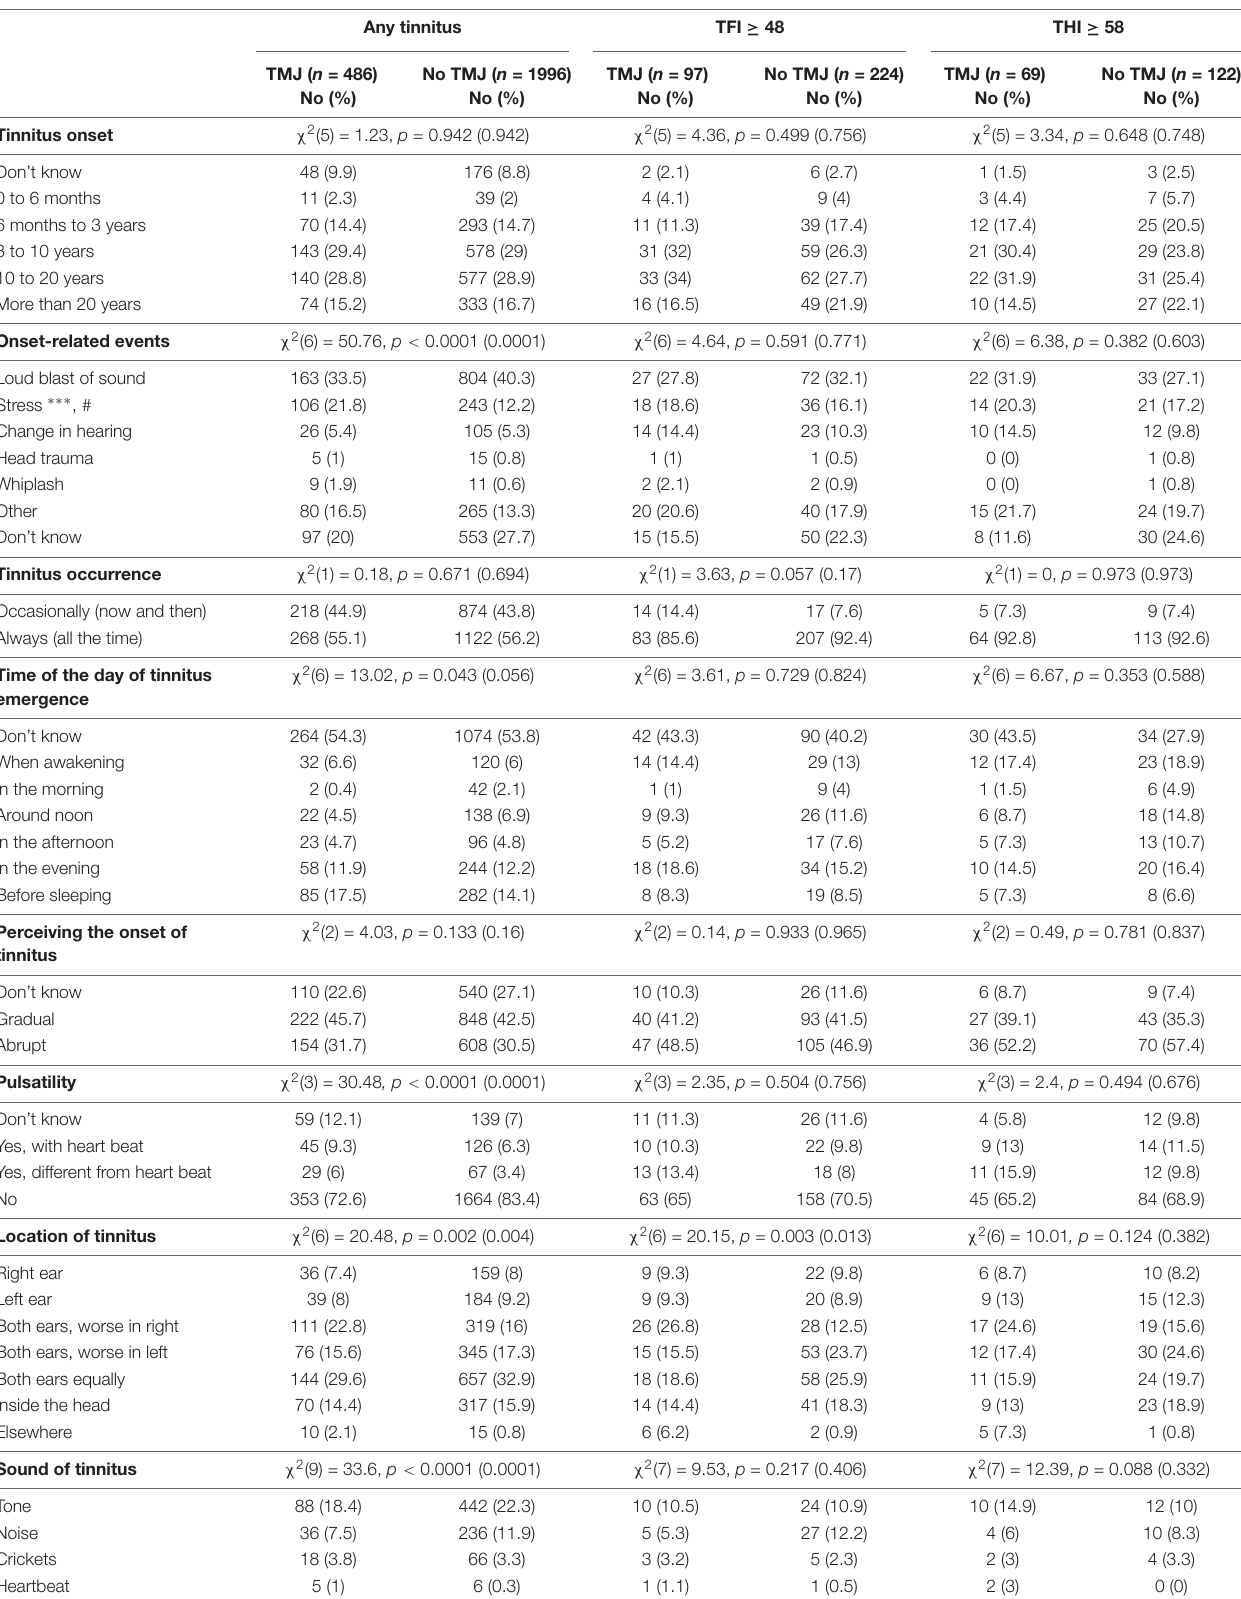
TABLE 3 | Phenotypic characteristics for subjects with tinnitus with or without TMJ complaints. Any tinnitus TFI ≥ 48 THI ≥